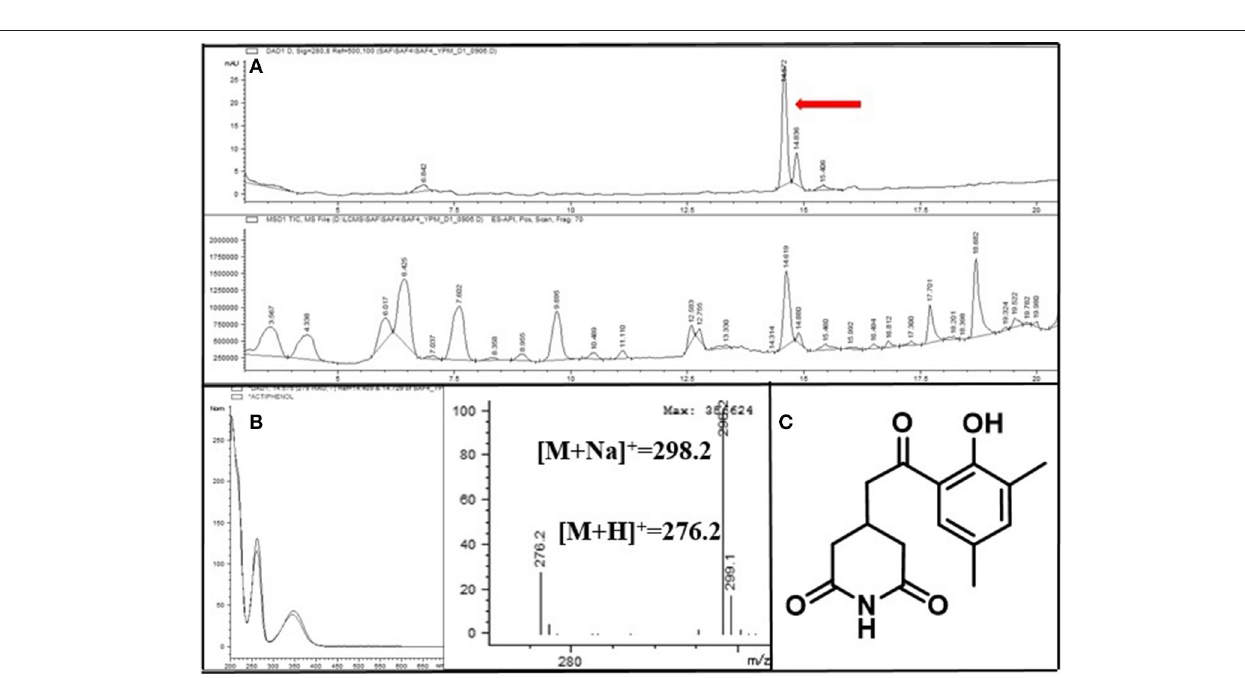
FIGURE 6 | (A) LC/MS chemical analysis of the liquid culture of the Streptomyces strain PrRe3I6. UV chromatogram at 280 nm (upper), and mass chromatogram (lower). (B) UV and mass spectra of the major secondary metabolite, actiphenol. (C) The chemical structure of actiphenol.